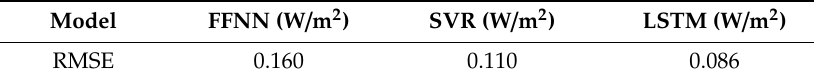
Table 13. Comparison between LSTM and other models.